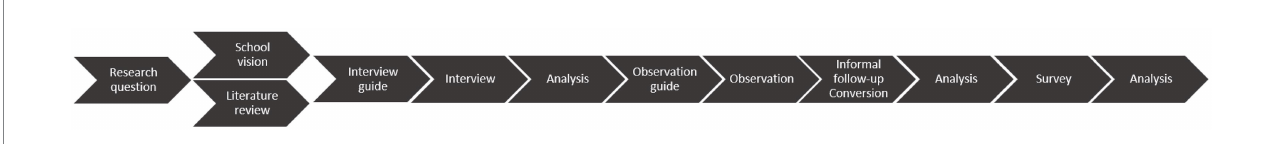
FIGURE 1 Research